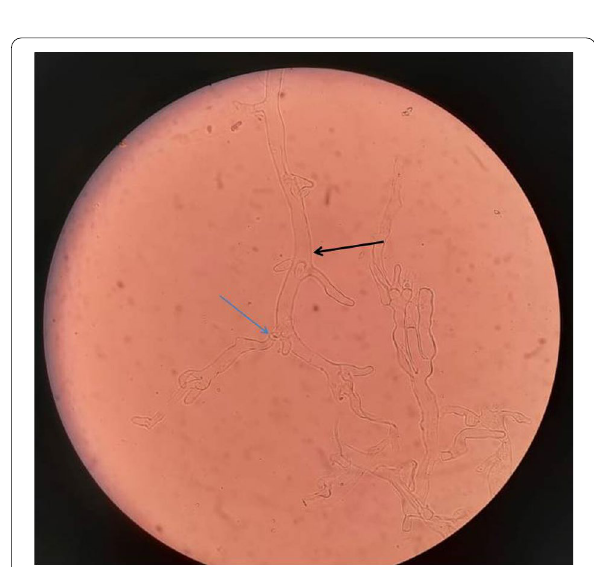
Fig. 2 Potassium hydroxide (KOH) mount showing ribbon-shaped aseptate hyphae (black arrow) showing branching at right angle (blue